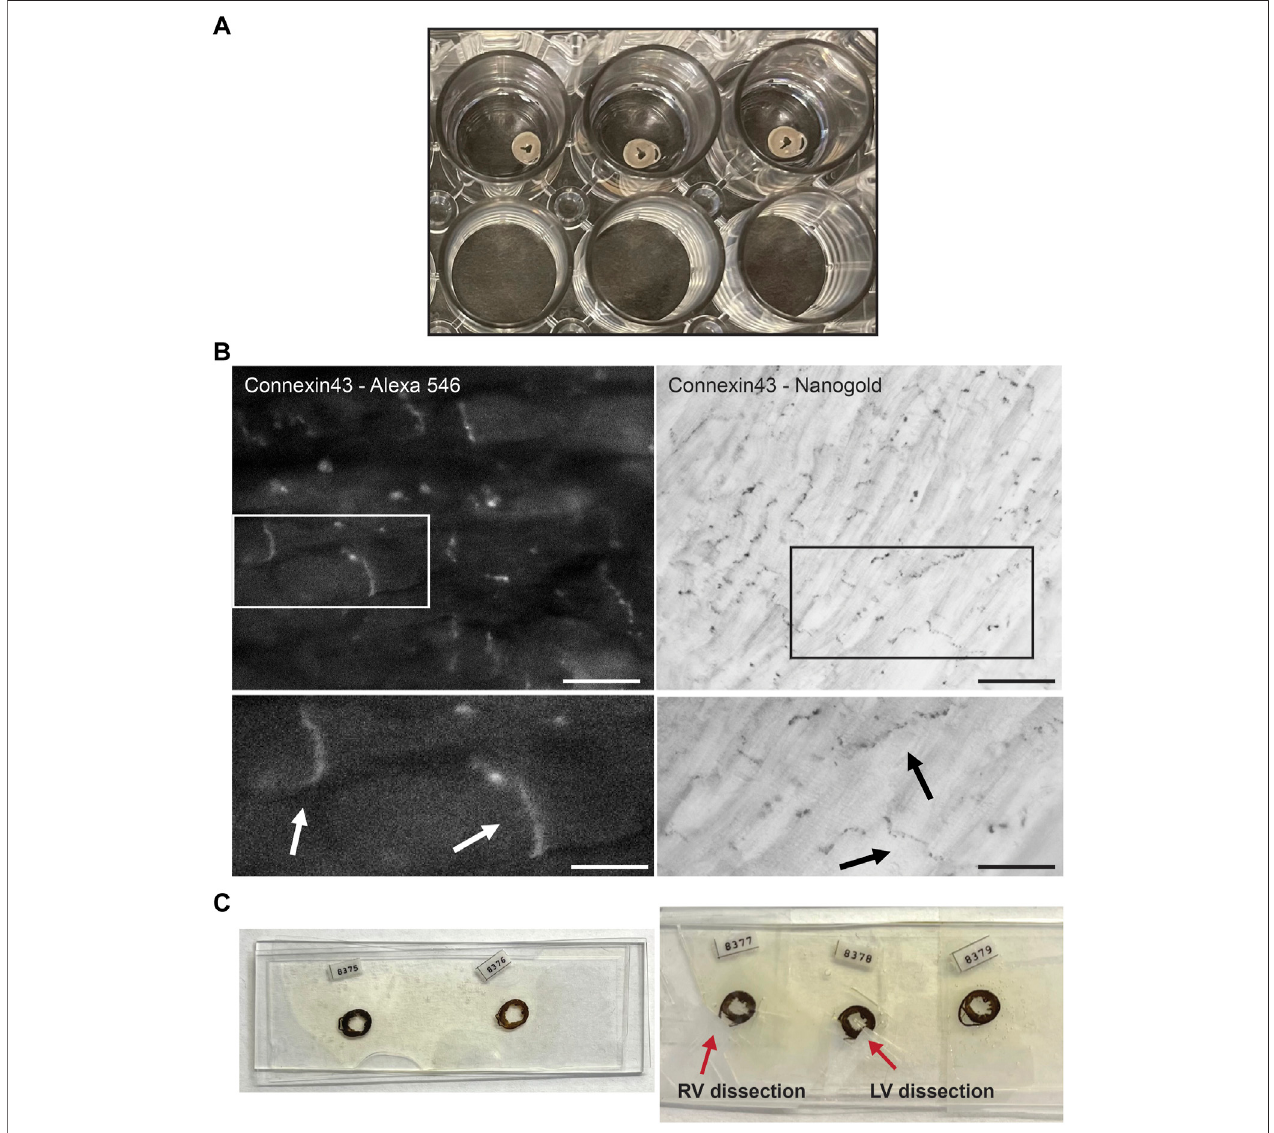
FIGURE 1 | Experimental setup of Connexin43 nanogold labeling in murine cardiac sections. (A) Thick cross sections from murine control hearts preserved in 4% paraformaldehyde, stored in a 24 wells plate. Sections are sectioned with a vibratome and of 200 µm thickness. (B) FluoroNanogold labeling of adult murine cardiac sections. Left panel : FluoroNanogold-546 labeled Connexin43 visualization by light microscopy. Scalebar: 10 µm. Zoom-in at indicated region presented in the panel below, arrowheads depict the intercalated disc (ID). Scalebar: 5 µm. Right panel : Nanogold visualization after silver enhancement of Connexin43 by light microscopy. Pictures in both frames are from the same cardiac section. Scalebar: 50 µm. Zoom-in at indicated region presented in the panel below, arrowheads depict the intercalated disc (ID). Scalebar: 10 µm. (C) Examples of fl at embedded cardiac sections after nanogold labeling. In the left panel the entire cross sections are presented. On the right, two representative examples are shown from dissections of left or right ventricular samples. RV: Right ventricle, LV: Left ventricle.